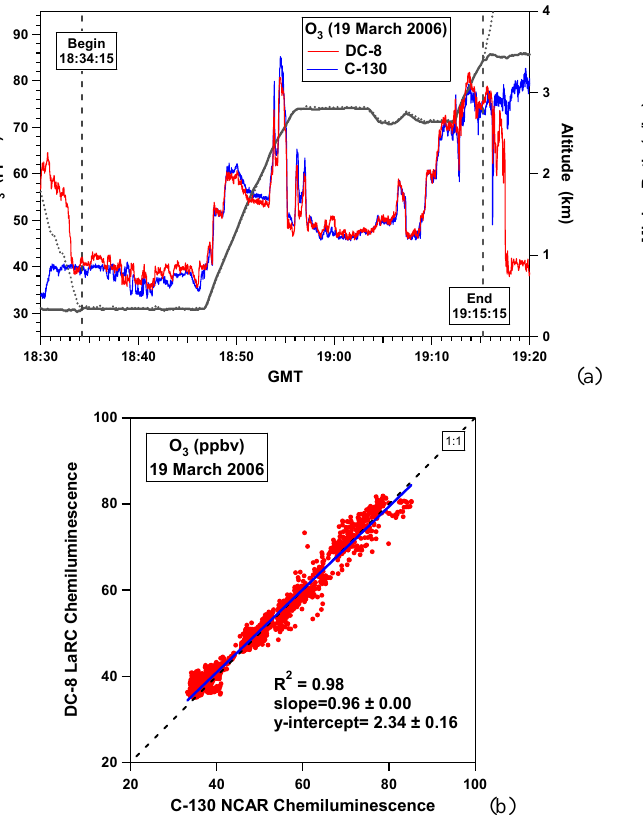
Fig. 3. (a) Timeseries for water during the intercomparison por- tion of the 15 May 2006 flight. The dotted line indicates the DC-8 altitude, solid thick line the C-130 altitude, red line DC-8 ozone, and blue line C-130 ozone. (b) Scatter plot and orthogonal dis- tance regression for the DC-8 and C-130 water intercomparison on 15 May 2006.